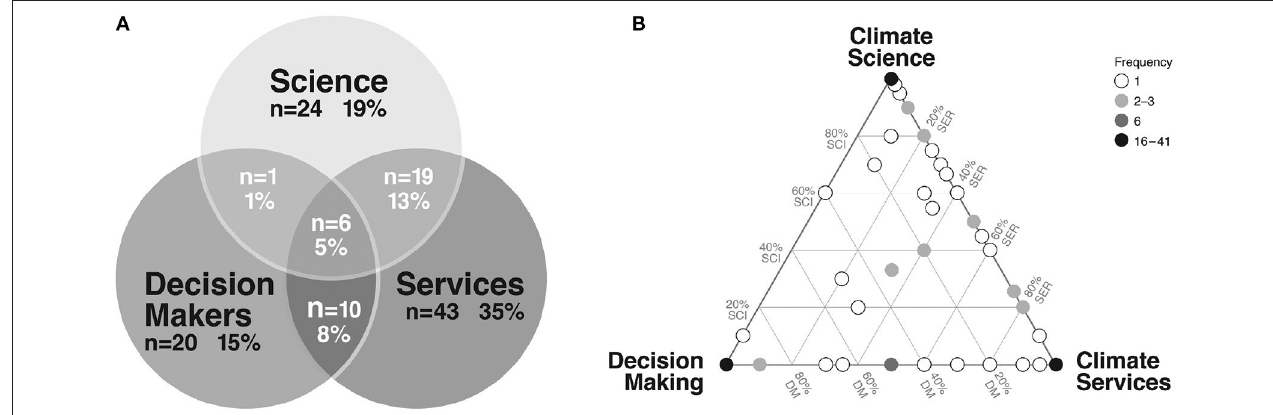
FIGURE 1 | Self-reported roles divided into our framework of science, services, and decision making. (A) Venn diagram of overlap among roles. Overlap in roles required a minimum of 20% (see Section Methods). (B) Ternary plot of self-reported roles. Circles located in the corners of the triangle represent individuals with discrete roles. Circles located on the outside edges represent individuals involved in two roles. Individuals self-reporting as having three roles are located in the interior of the triangle.